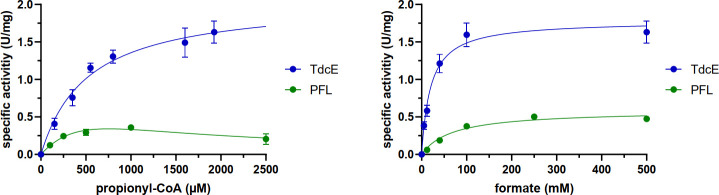
Michaelis-Menten graphs of PFL and TdcE for propionyl-CoA and formate (see Materials and methods section for exact conditions).Error bars show standard deviation of three replicates. The data was fit to the Michaelis-Menten equation, except for PFL with propionyl-CoA, for which the data was fit to a substrate inhibition equation. The kinetic parameters are listed in Table 1.